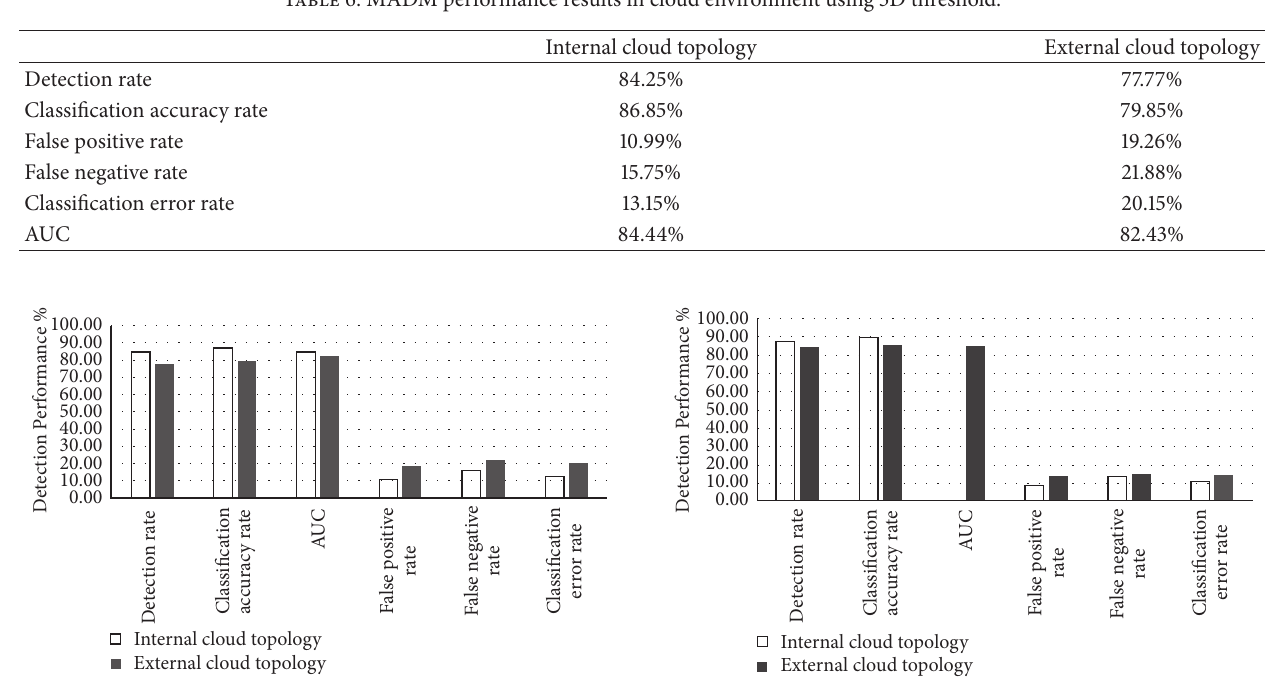
Figure 4: MADM performance results in cloud environment using 3D threshold.